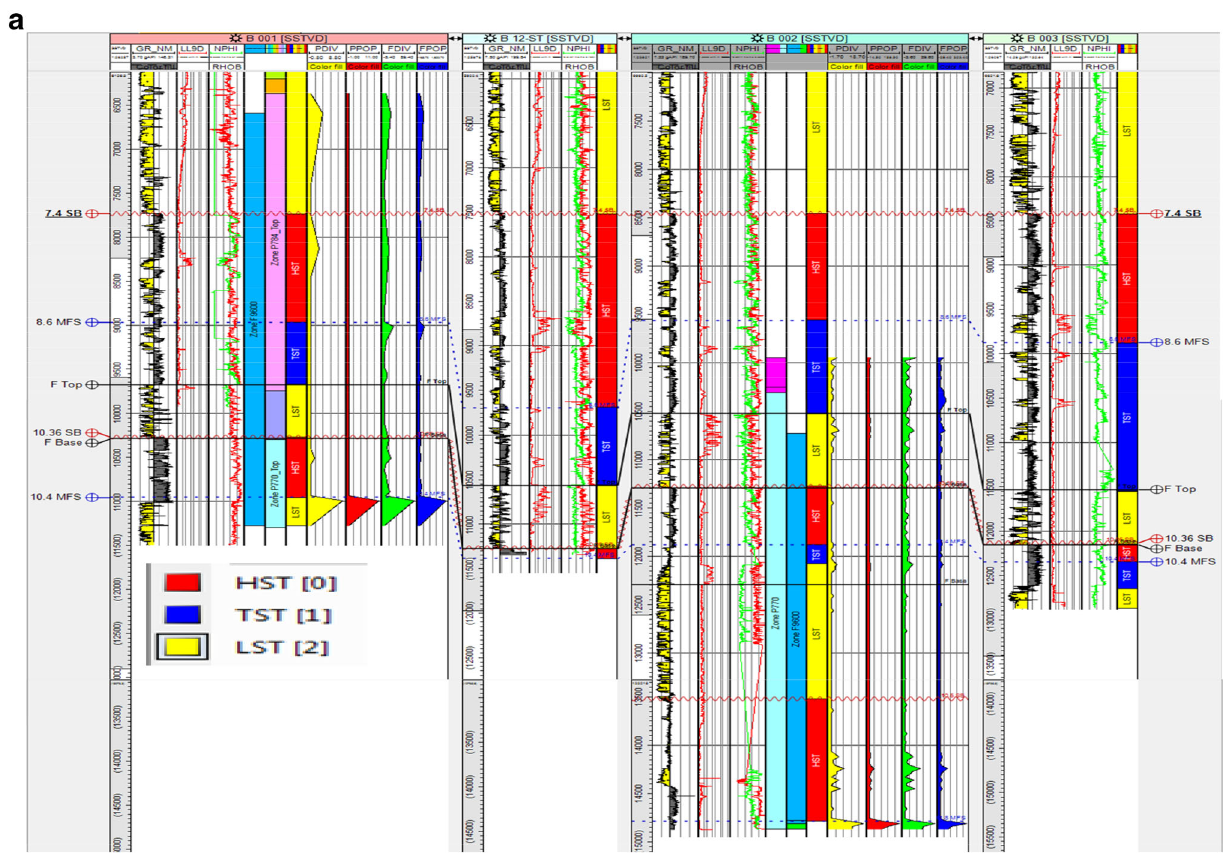
Fig. 6 a Sequence stratigraphic framework of upper interval across field. b Sequence stratigraphic framework of the lower interval across